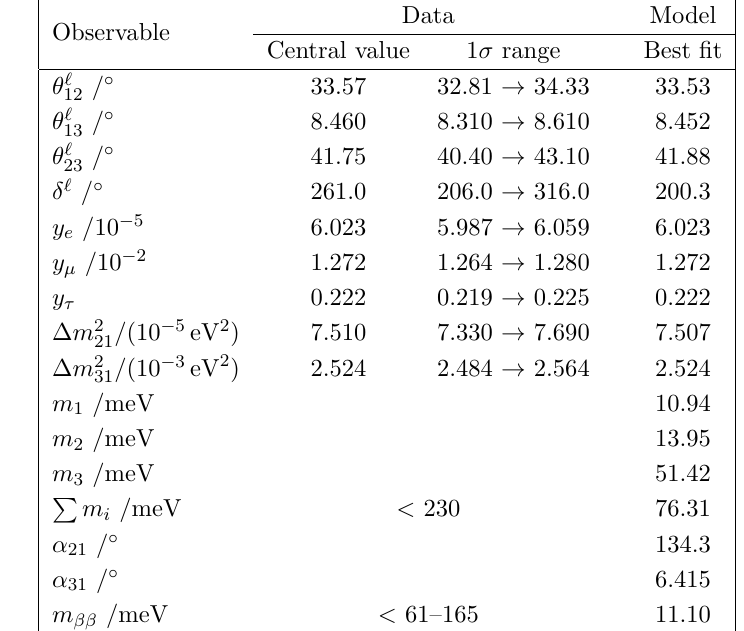
Table 3. Model predictions in the lepton sector for tan (cid:12) = 20, M SUSY = 1 TeV and (cid:22) (cid:17) The observables are at the GUT scale. The lepton contribution to the total (cid:31) 2 is 1.2. The neutrino masses m i as well as the Majorana phases are pure predictions of our model. The bound on P m i is taken from [91]. The bound on m (cid:12)(cid:12) is taken from [92].